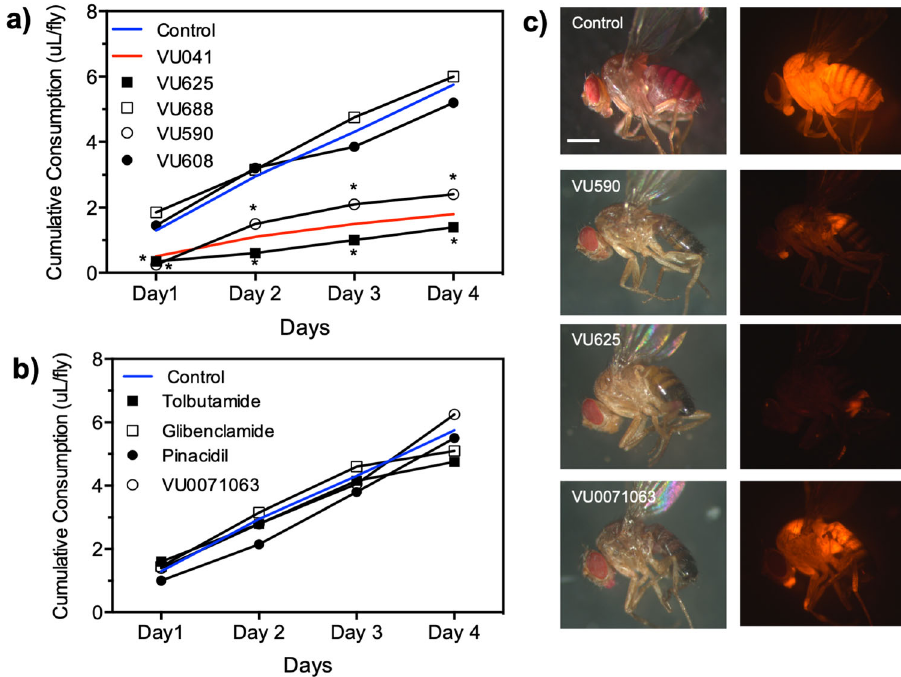
Fig. 6 Impact of Kir channel modulators to the non-hematophagous fl y, Drosophila melanogaster . a Measurement of cumulative sucrose consumption by adult D. melanogaster over a 4-day period using the CAFE feeding assay with Kir modulators. Total consumption was compared to control fl ies (blue line) and VU041 (red line). Statistical signi fi cance compared to control consumption is denoted by an asterisk where * P < 0.05. b Measurement of cumulative sucrose consumption by adult D. melanogaster with K ATP channel modulators. For b , c , data points represent the mean ( n > 25) cumulative consumption of individual fl ies. Error bars for panels b , c have been omitted for clarity. c Representative images of reduced feeding are shown by the inclusion of rhodamine B into the sucrose solution and allowing access to feed for 30 min. Scale bar equals 200 µ m. See Supplemental Data 6 for underlying